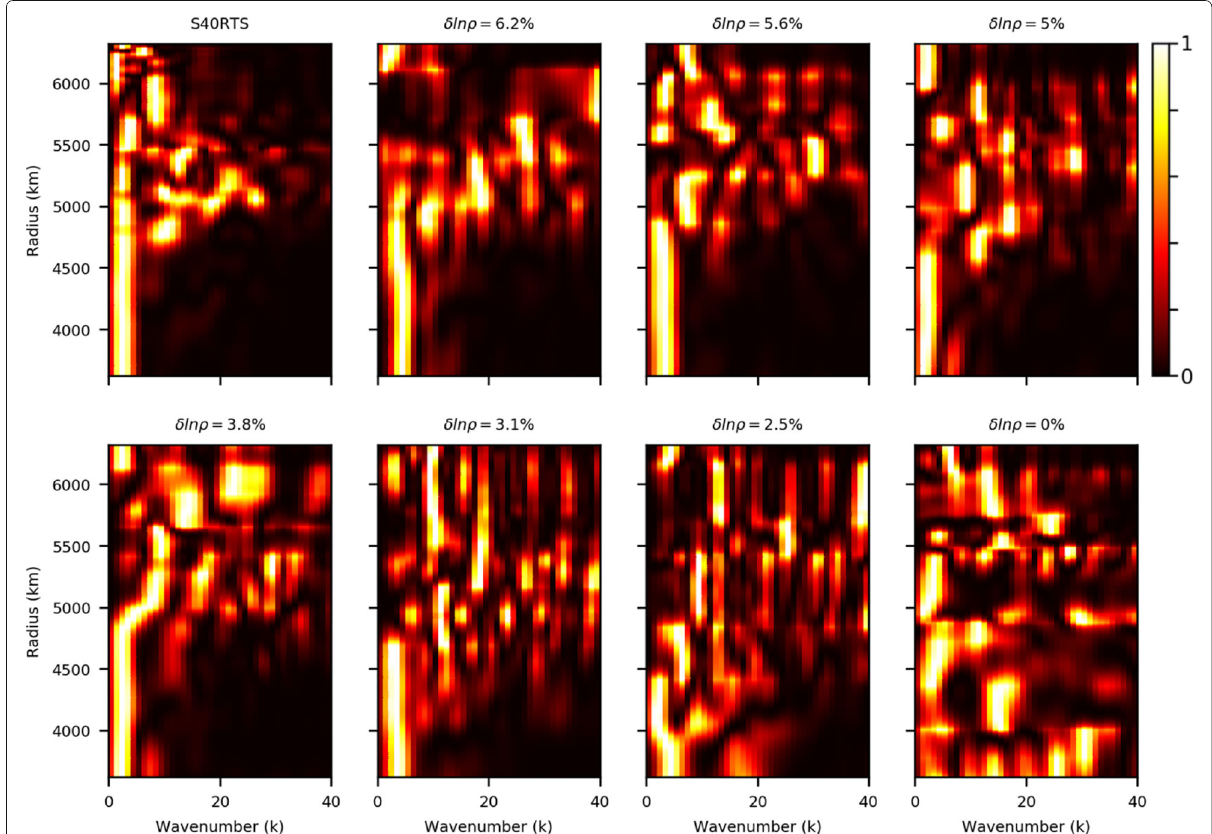
Fig. 5 Power spectral density plots for S40RTS and the tomographically filtered models as imaged beneath the Pacific plate. Spectral power is normalized to the maximum power at each depth and plotted as a function of wavenumber and radius. High power at low wavenumbers characterize the lower mantle in S40RTS and the filtered geodynamic models when δρ ≥ 3.1%. This is due to the formation of large thermochemical structures at this density contrast. Below this value, power in the lower mantle is more randomly distributed across high and low wavenumbers due to a lack of broad-scale structure. The upper mantle of all geodynamic models contains more power at higher wavenumbers compared to